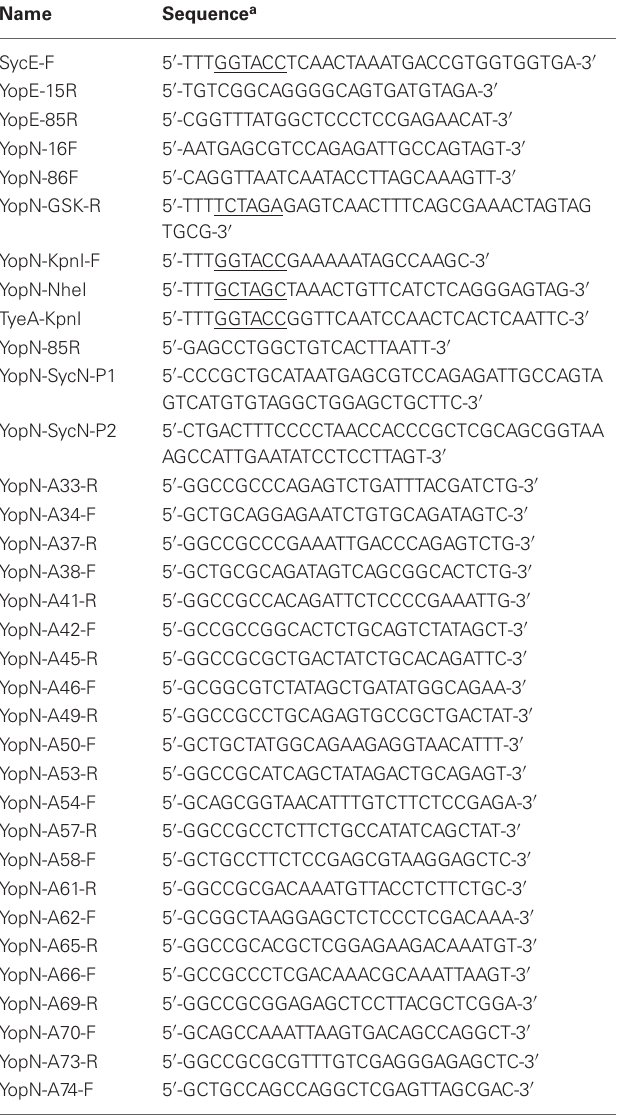
Table 2 | Oligonucleotides used in this